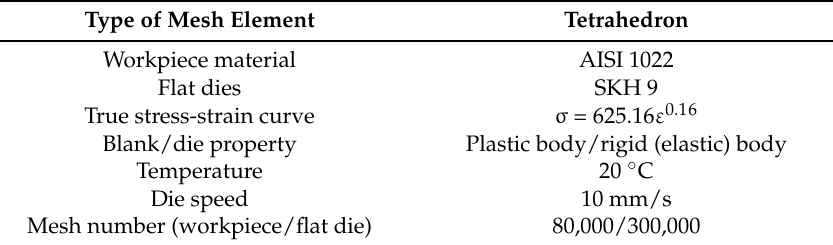
Table 1. DEFORM simulation parameters.